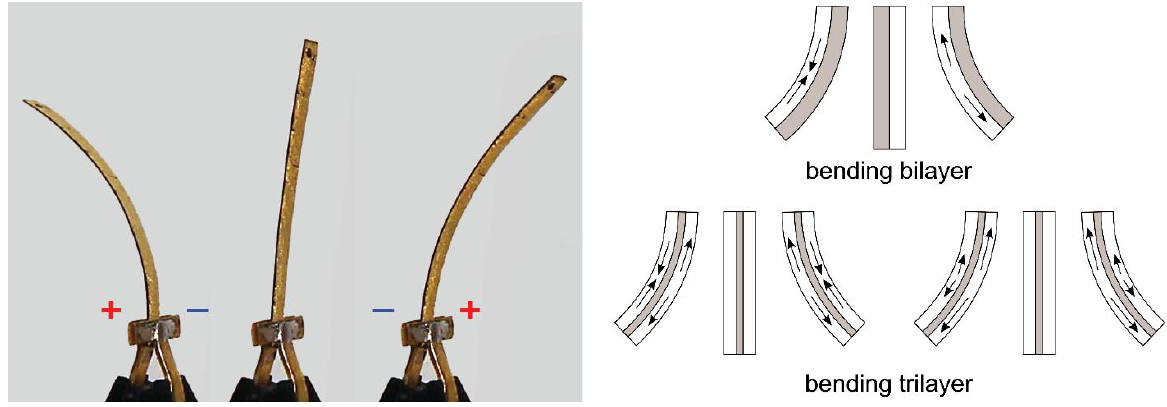
Figure 1. Bending ionic electromechanically active polymer (IEAP)